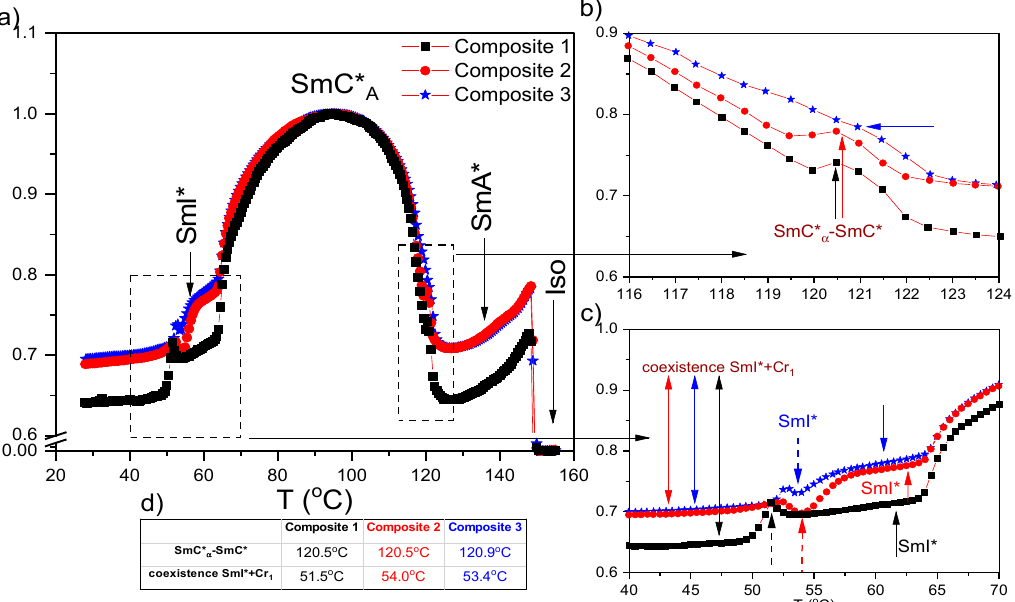
Figure 3. Temperature dependence of normalized transmitted light intensity during cooling ( a ), the selected temperature range in the vicinity of the SmC* α –SmC* ( b ), and the SmC* A –SmI*–Cr 1 phase transition ( c ), determined phase transition temperature for SmC* α –SmC*, and temperatures at which are observed the coexistence regime ( d ); the accuracy of the temperature determination is equal to ±0.1 °C.